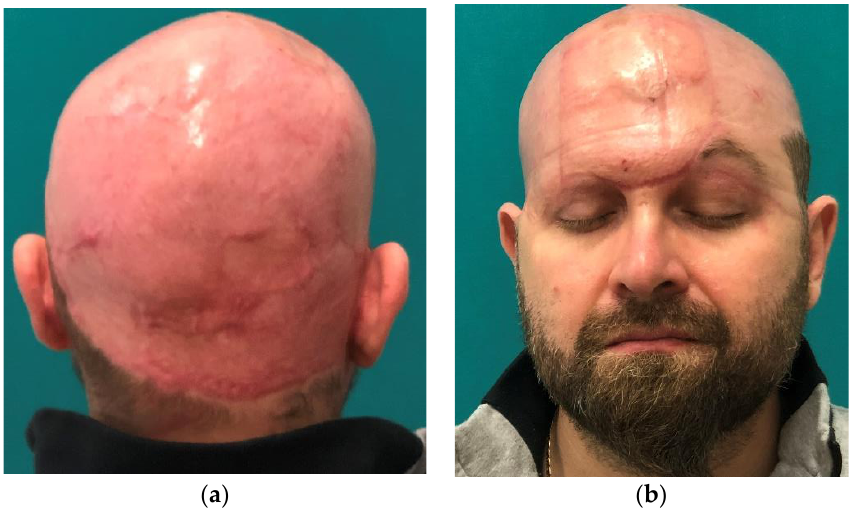
Figure 4. Post-operative images of one of the patients at three months. ( a ) posterior view ( b ) frontal